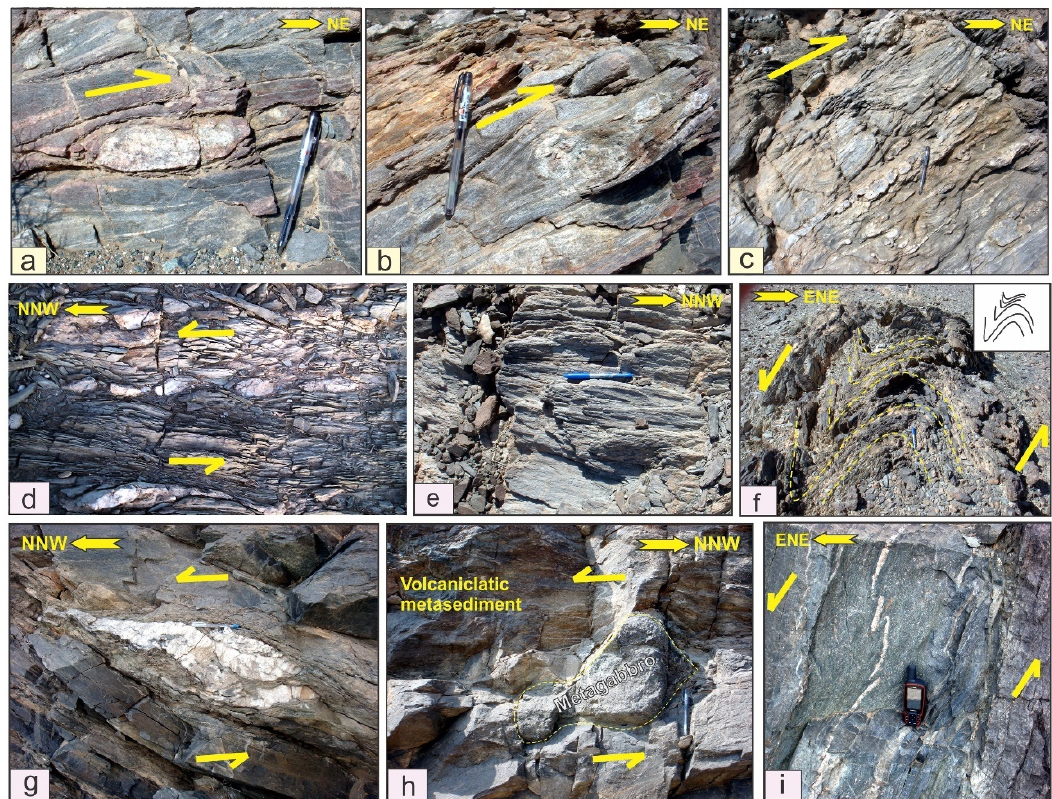
Figure 13. Field photographs of structural elements in the study area: ( a ) Foliation-parallel shearband boudins of quartz along S2 foliation in volcaniclastic metasediments,Wadi Rahaba, indicating sinistral transpressive shearing along thrust planes, ( b ) Metagabbro prophyroclast in volcaniclastic metasediments indicating top-to NE sense of movement along thrust planes, Wadi Beitan, ( c ) Asymmetrical folds and shearband boudins of quartz veins along S2 foliation in volcaniclastic metasediments, Wadi Rahaba, indicating top-to NE sense of movement along thrust planes, ( d ) Strike–slip shear zones appear as steep ductile zones in sheared metavolcanics which sheared the S2 foliation. S3 foliation strike N20–30° W with steep dip toward the SW, Wadi Beitan, ( e ) Crenulation lineation in metasedisment with a subhorizontal plunge to the NNW, ( f ) Asymmetric tight and reclined folds in volcaniclastic metasediments, south of Gabal Abu Darh, indicating sinistral sense of shearing,( g , h ) Quartz and metagabbro asymmetric prophyroclast in volcaniclastic metasediments, Wadi Um Teneidab and Wadi Rahaba, ( i ) en-echelon folded quartz veins in schistose metavolcanics, Wadi Hutib, indicating sinistral sense of shearing.